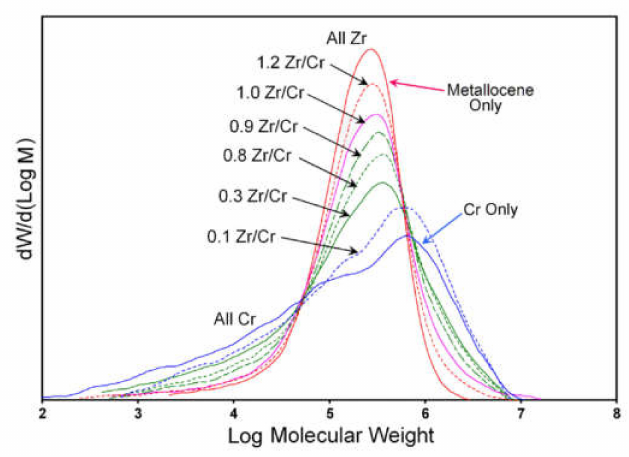
Figure 1. MW distribution of polymers produced by combinations of chromium and metallocene catalysts on the same